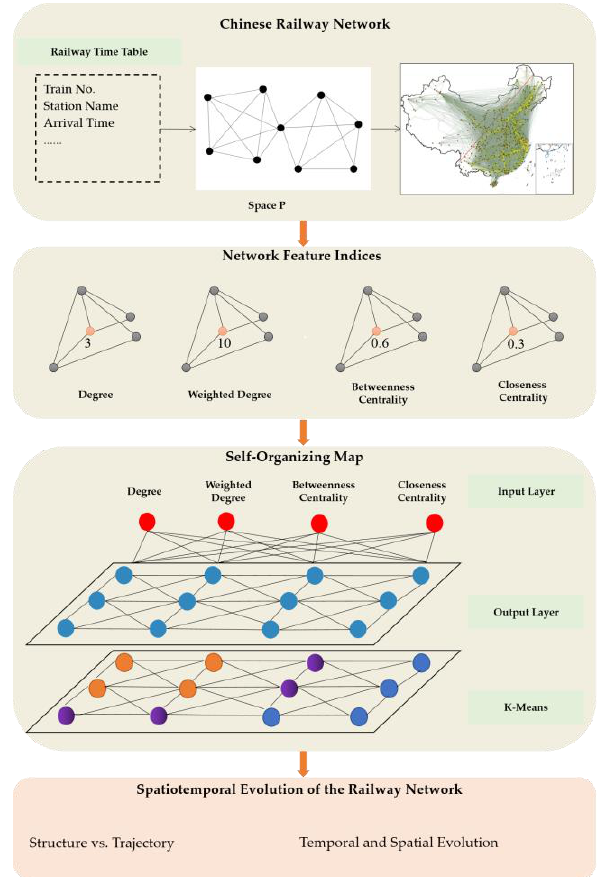
Figure 1. Overall research